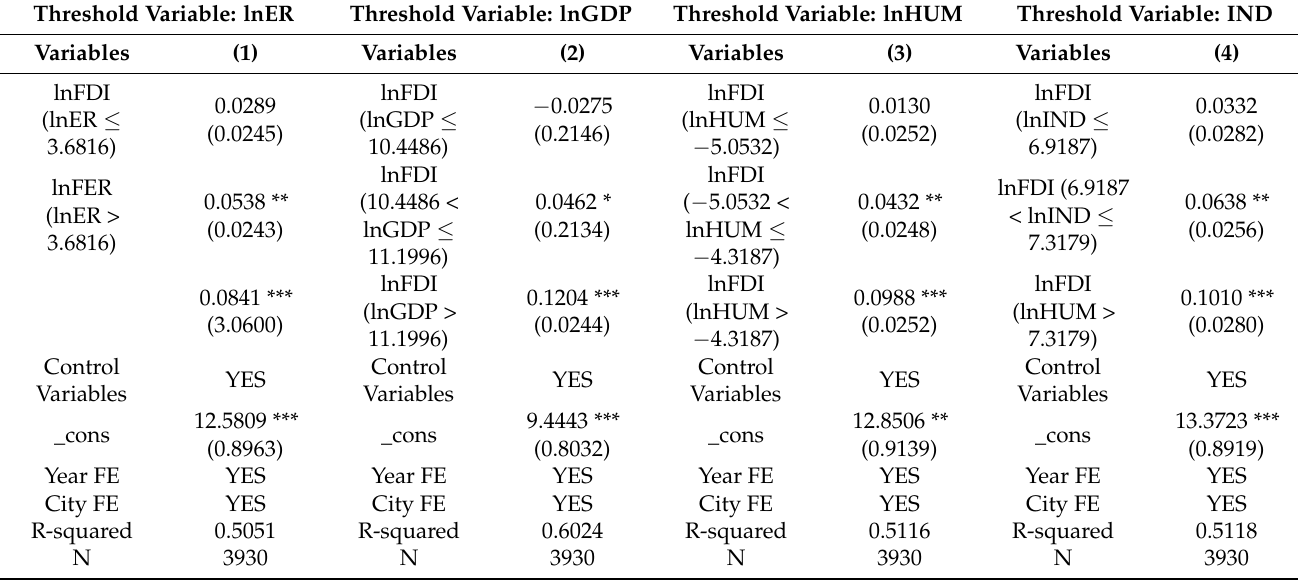
Table 6. Robustness Test replacing the explained variables.